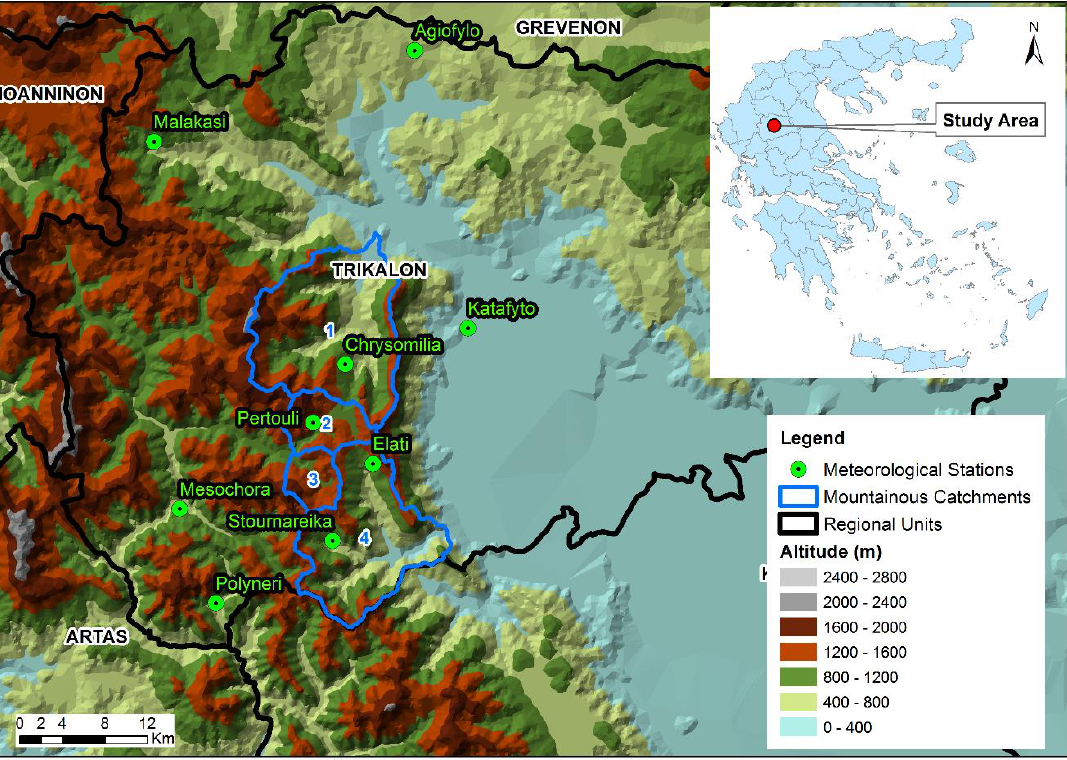
Figure 1. The study area and location of stations.